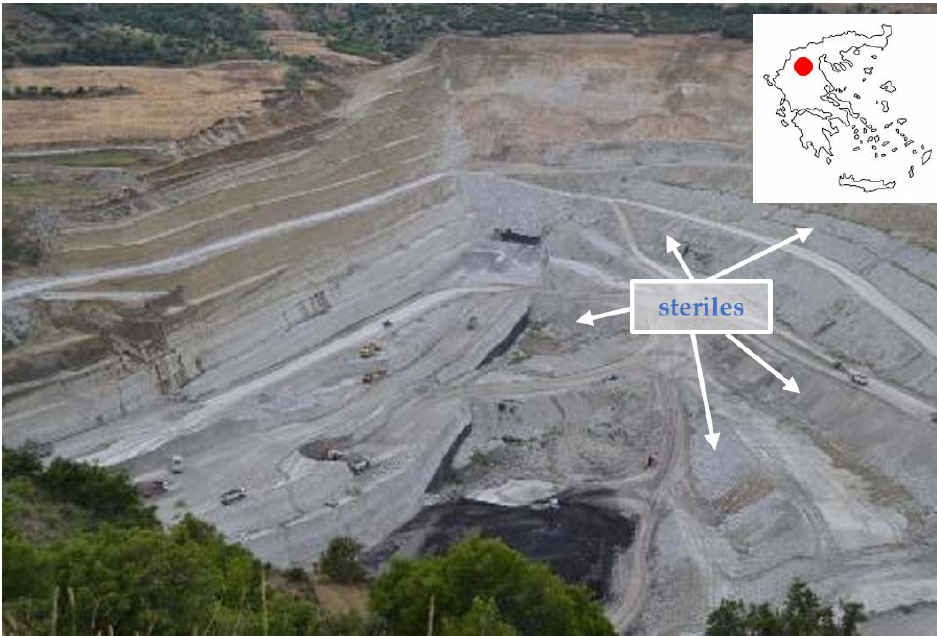
Figure 1. Top view of the open-pit mine in Prosilio region (Kozani, NW Greece) with indicative sampling points (white arrows) of the studied clayey steriles.